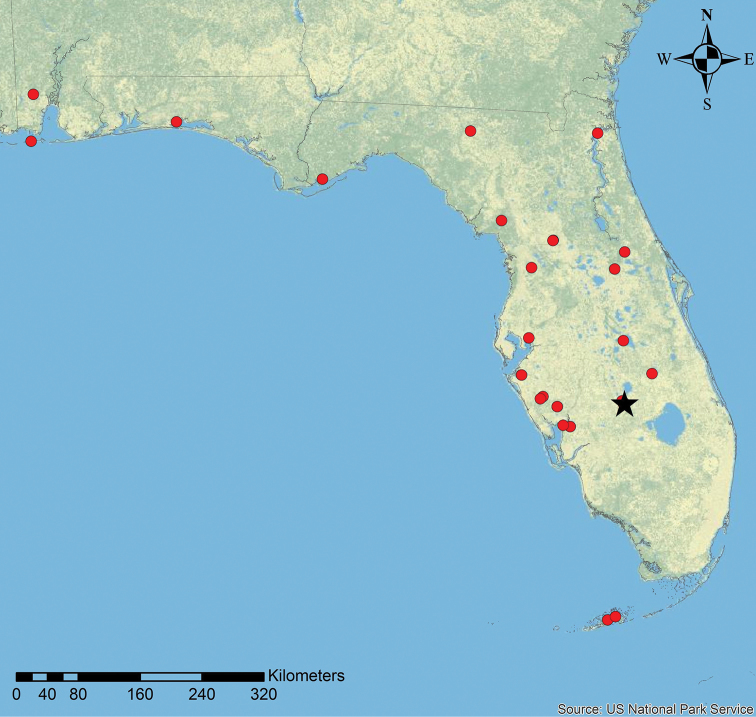
Geographic distribution of N.
deyrupi (black star) and its host N.
wojciki (red circles). Host distribution data was supplemented with additional information from antmaps.org (Janicki et al. 2016).